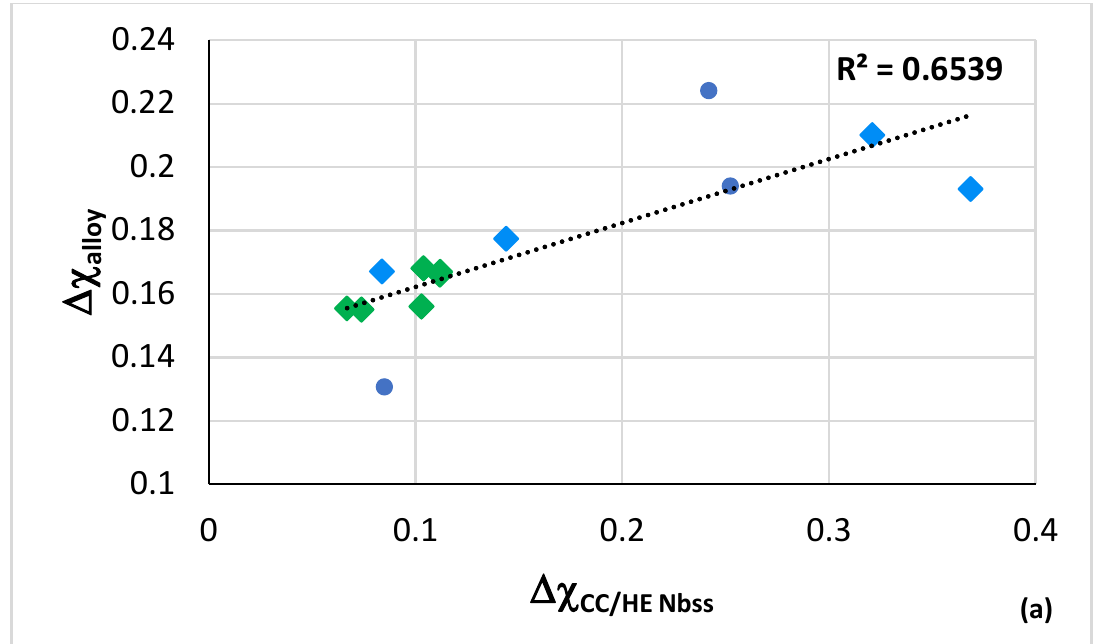
Figure 5. ( a ) Parameters VEC,  and  of CC/HE Nb ss in alloys where this type of solid solution was observed and ( b ) details of  CC/HE Nbss. Colours: blue VEC, brown  , green  . Alloys 1 to 12 the same as in Figure 4. HE Nb ss in TT4-AC. For nominal alloy compositions and references see Appen- dix A. RM(Nb)ICs (5, 8 – 10) and RM(Nb)ICs/RCCAs (1 – 4,6,7,11,12).